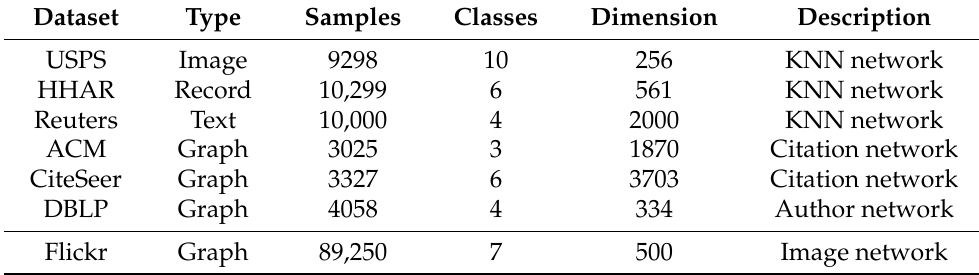
Table 1. The statistics of the